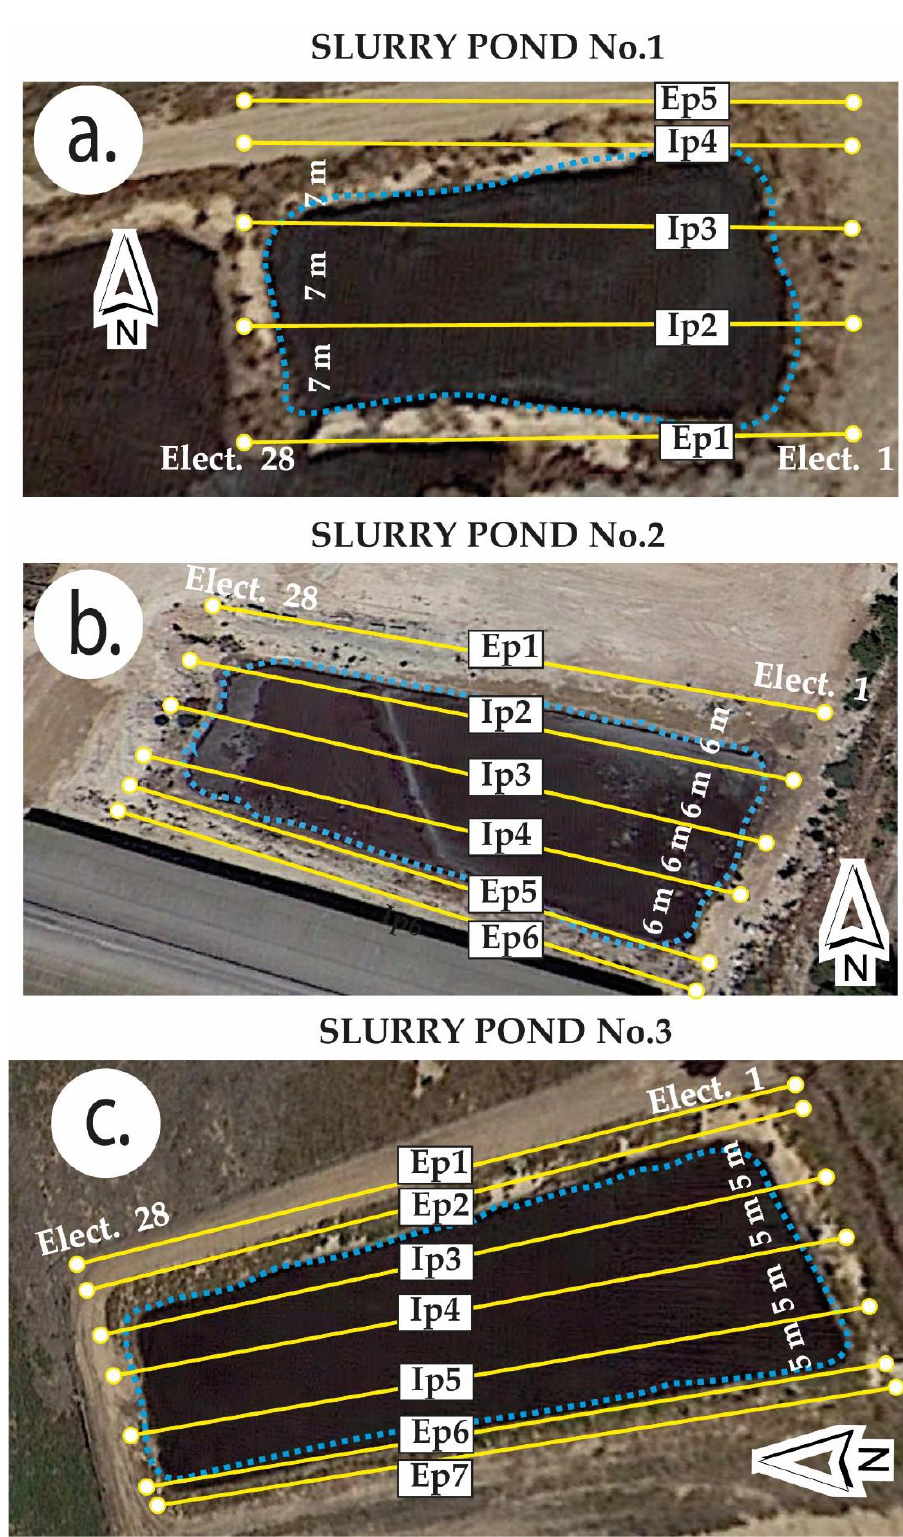
Figure 3. Schematic layout of ERT external and internal profiles at ( a ) slurry pond No. 1, ( b ) slurry pond No. 2, and ( c ) slurry pond No. 3.